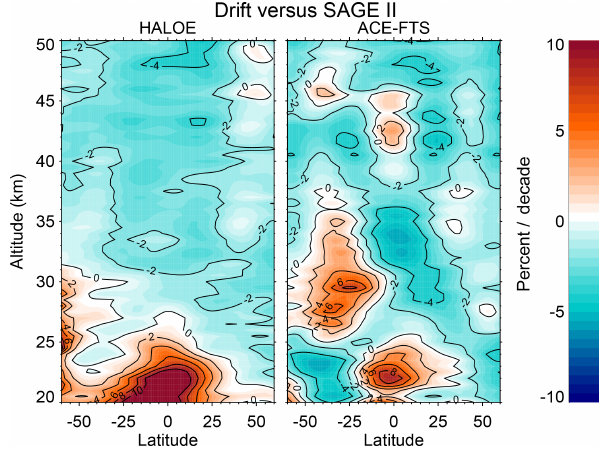
Figure 14. Same as the STS results in Fig. 11 except the re- gression no longer assumes any kind of drifts between the instru- ments. Reduction in potential recovery trends can be as high as ∼ 2%decade − 1 for this particular combination of data